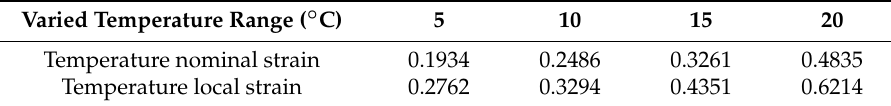
Table 13. Temperature strain at the bottom of